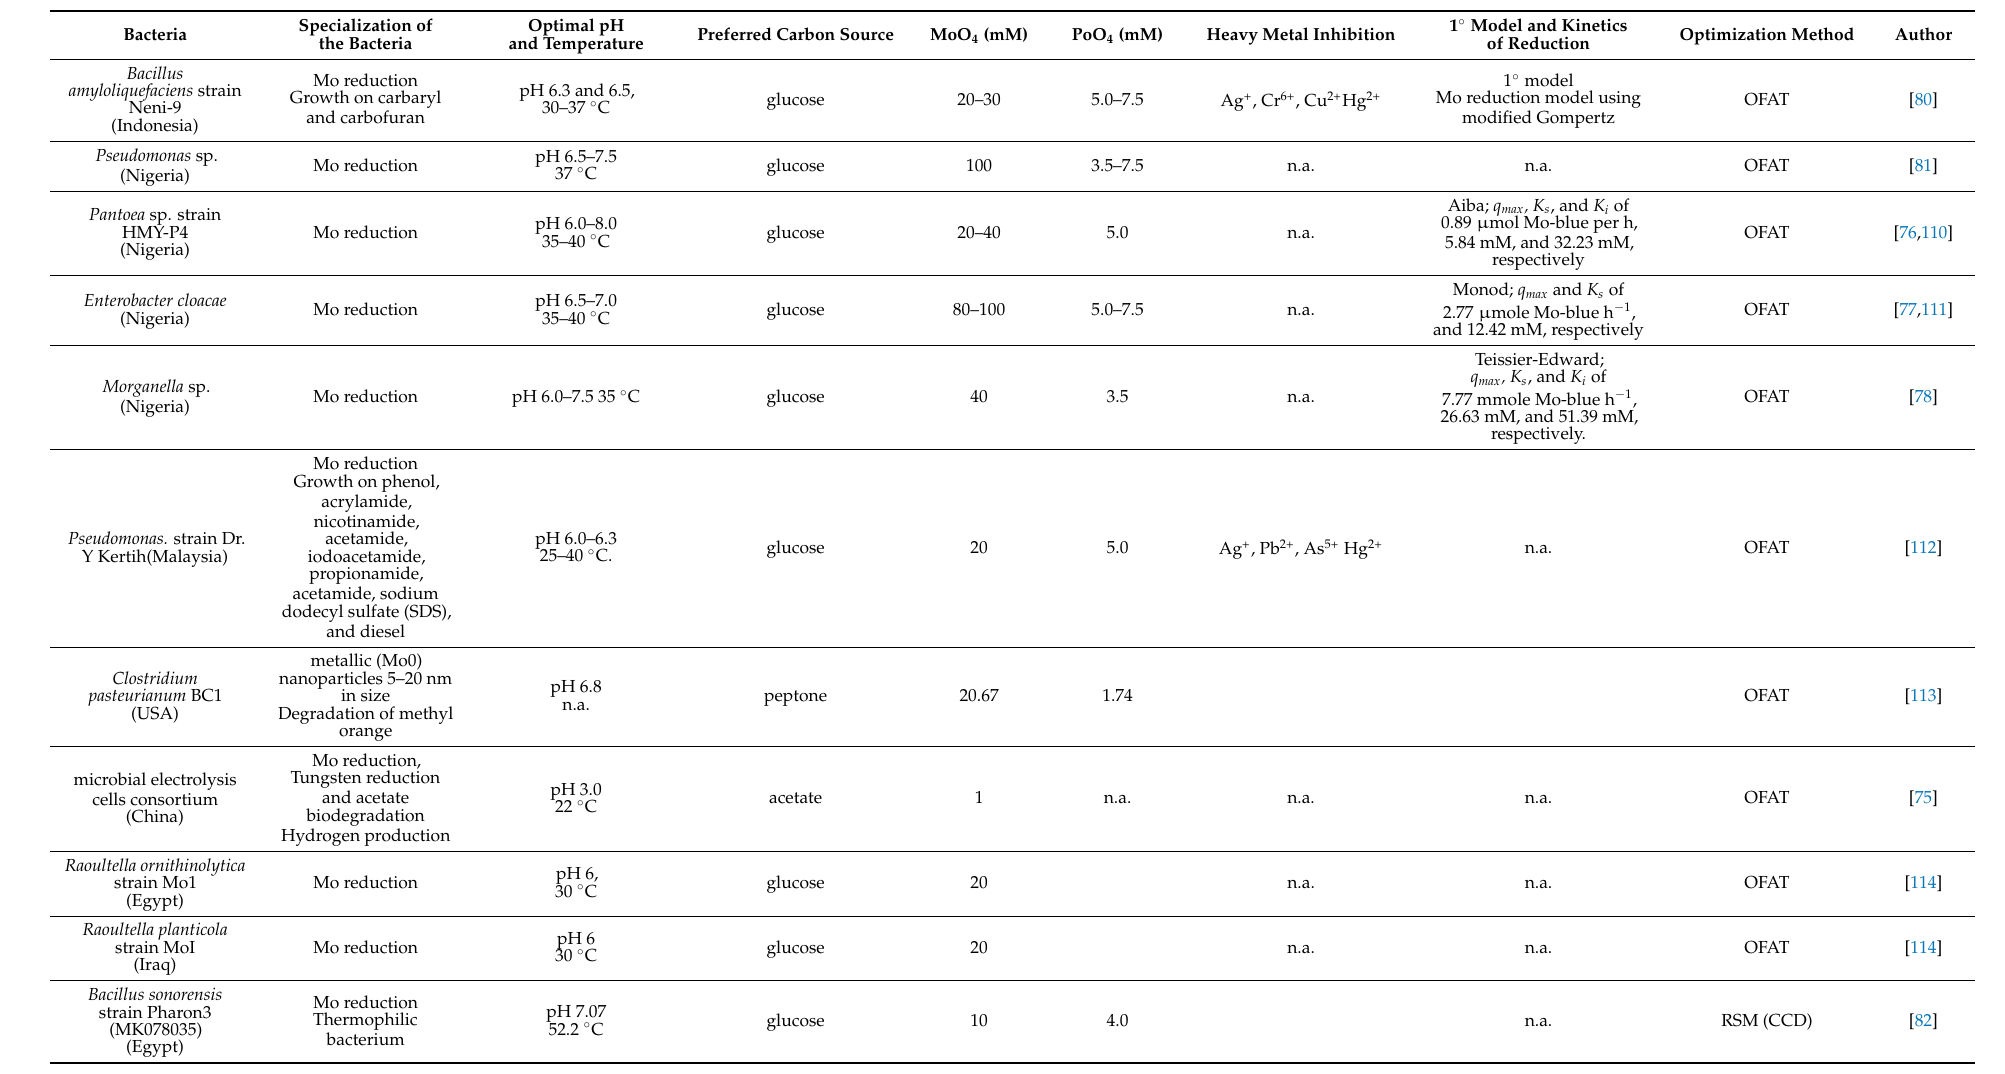
Table 1. Characteristics molybdenum-reducing